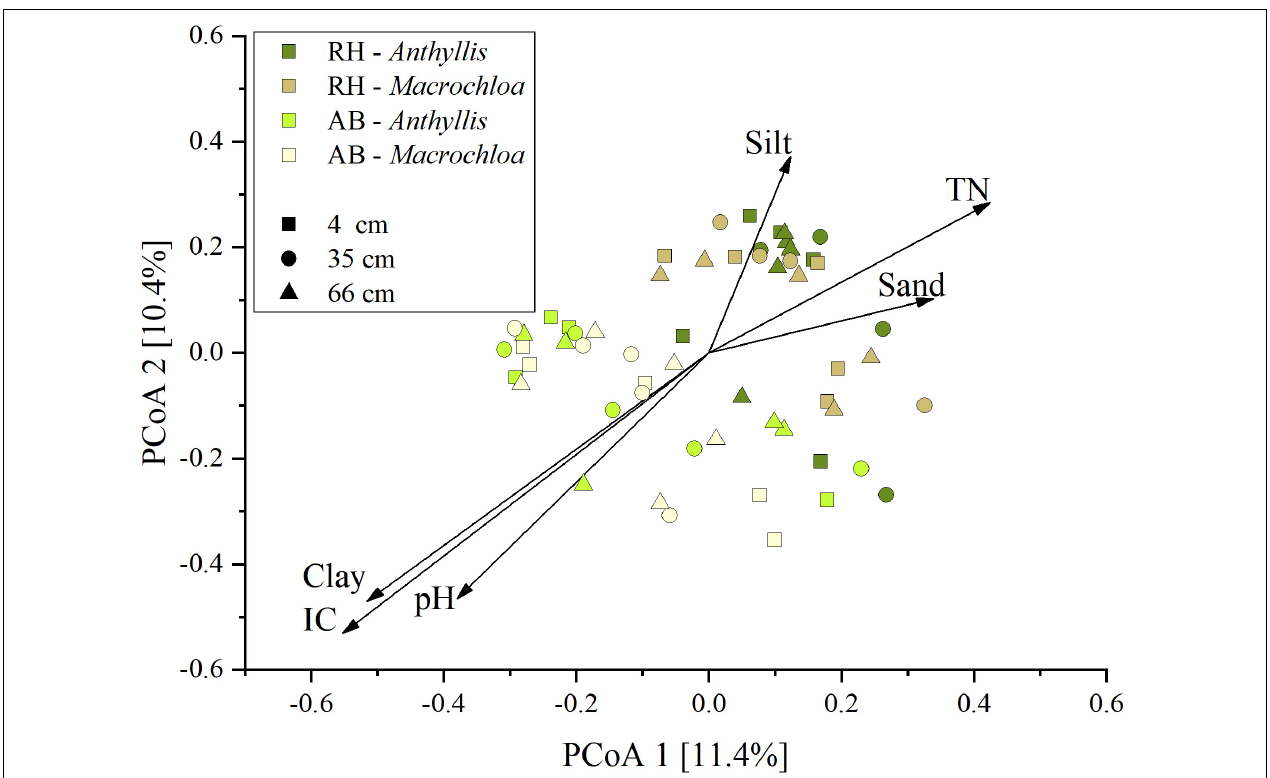
FIGURE 3 | Principal Coordinates Analysis (PCoA) of the prokaryotic community composition based on 16S rRNA gene amplicon sequence variants (ASVs), plotted with the environmental variables that significantly ( p < 0.05) influenced the community composition. Length of the arrow displays the extent of influence of the abiotic parameter on the community